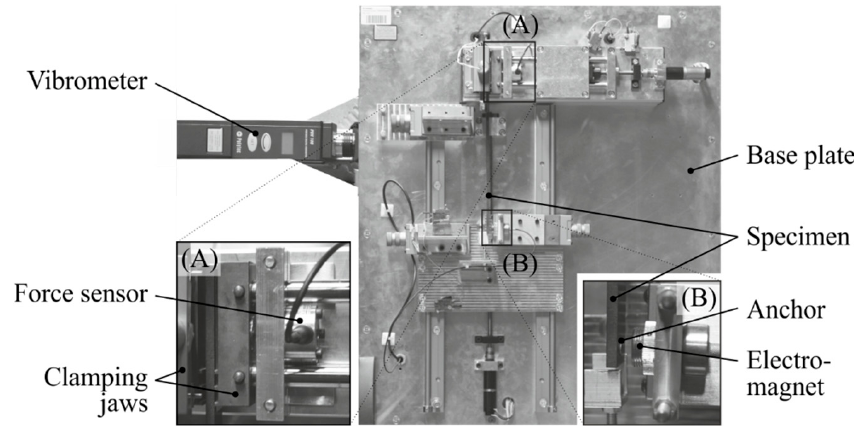
Figure 1. Modular test stand for determination of dynamic material properties [23]. A beam-shaped specimen is clamped at one end (A) using damping minimized clamping jaws. The clamping force is measured for repeatability of the measurement. The excitation of the test specimen is done at the free end (B) by means of an electromagnet. The excitation occurs at the first natural frequency, which in this case was between 17 and 37 Hz. For non-ferromagnetic specimens, an iron washer is attached at the free end in order to allow the electromagnetic excitation. A laser vibrometer is used to measure the vibration amplitude that results from dynamic excitation. This allows contactless and non-interacting detection of the vibration. To reduce noise and increase measurement accuracy, a retroreflective dot was bonded to the specimen at the measurement position. The measured timeseries are then evaluated using curve-fitting algorithms. Measuring the steady-state amplitude at several frequencies allows to determine the frequency of the resonant peak and corresponding 3 dB-bandwidth.